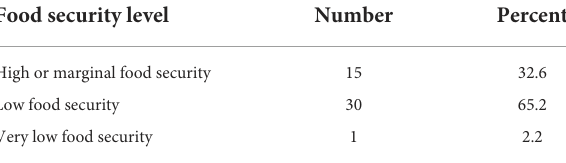
extension of the probit method and an appropriate approach to dealing with censored data. The coefficients are calculated using the maximum log-likelihood function, which indicates the consistency of the model (27).